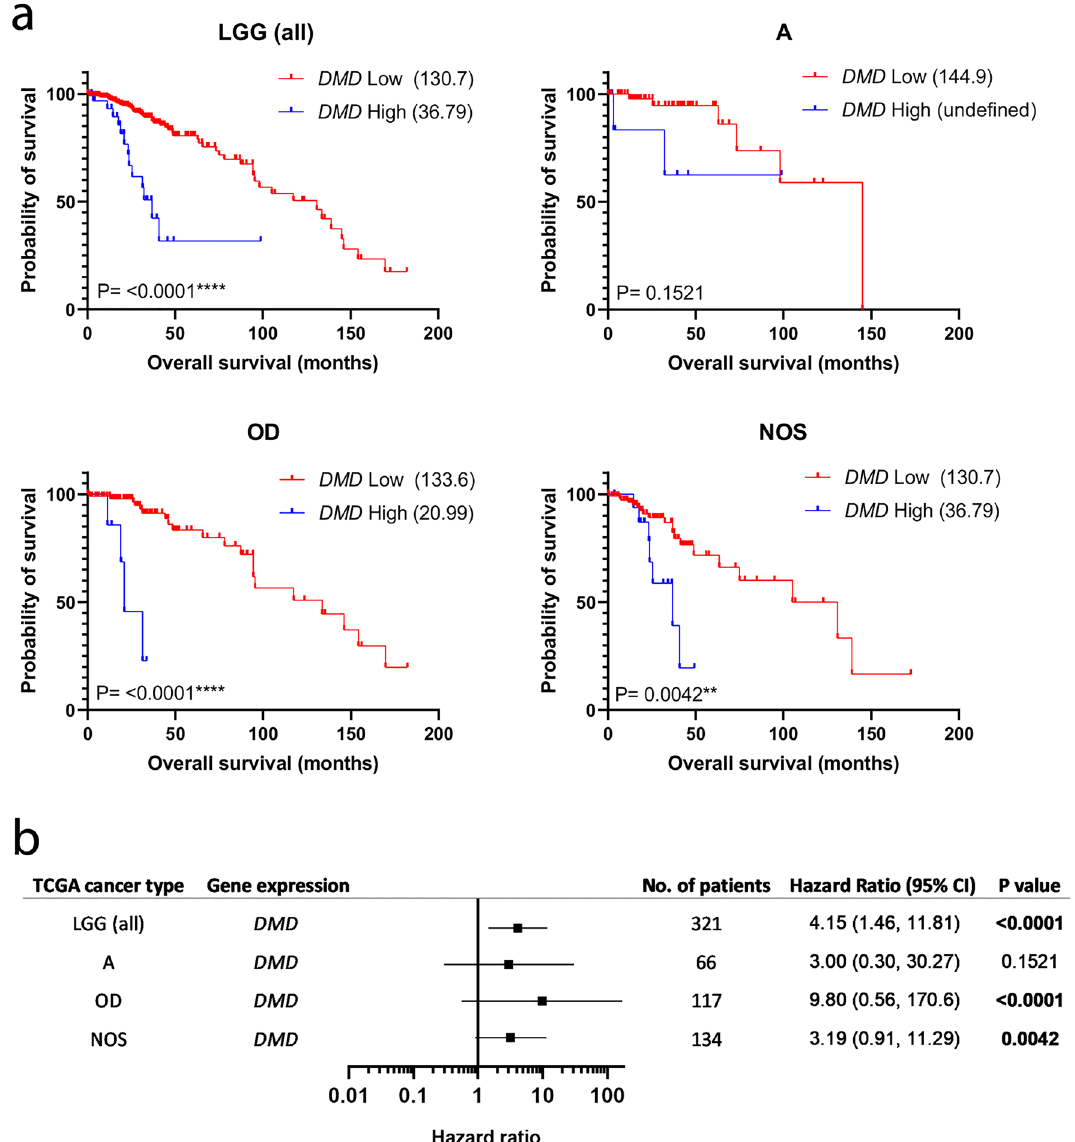
Figure 1. High DMD expression is significantly associated with poor survival in LGG. ( a ) TCGA RNAseq data from WHO grade II LGG cases was dichotomised into high (blue) and low (red) DMD expressing groups and survival analysis performed in GraphPad using the log-rank test. Tumour subtype analysis was also performed. Numbers in brackets are median overall survival times in months. ( b ) Forest plot revealing the log-rank hazard ratio with 95% confidence intervals and number of patients for each group. A astrocytoma, OD oligodendroglioma, NOS not otherwise